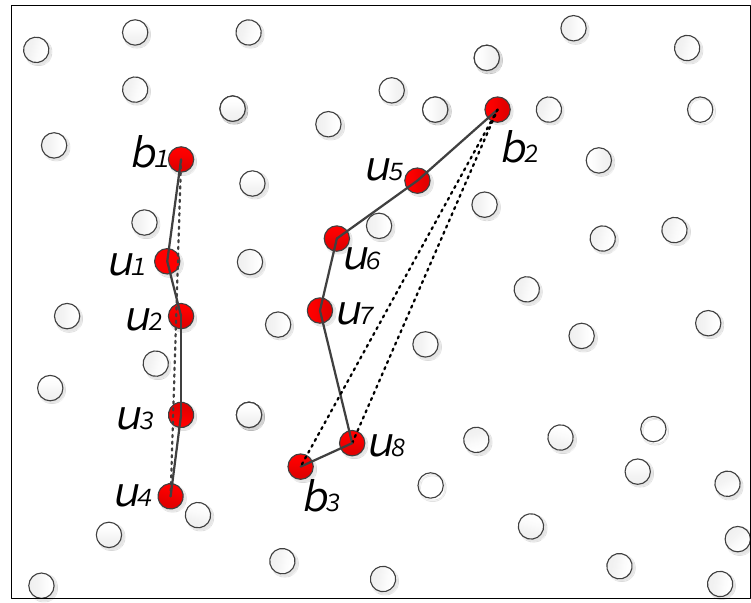
Figure 5. Diagram for distance estimation.